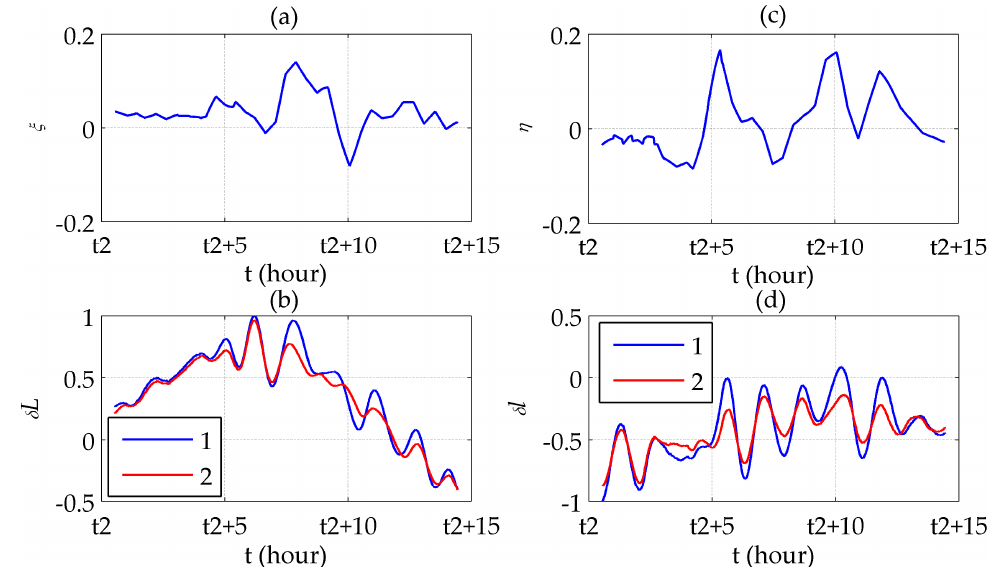
Figure 13. Compensation results of Segment II-5: ( a ) ξ ; ( b ) Latitude errors before (line 1) and after (line 2) compensation; ( c ) η ; ( d ) Longitude errors before (line 1) and after (line 2) compensation.